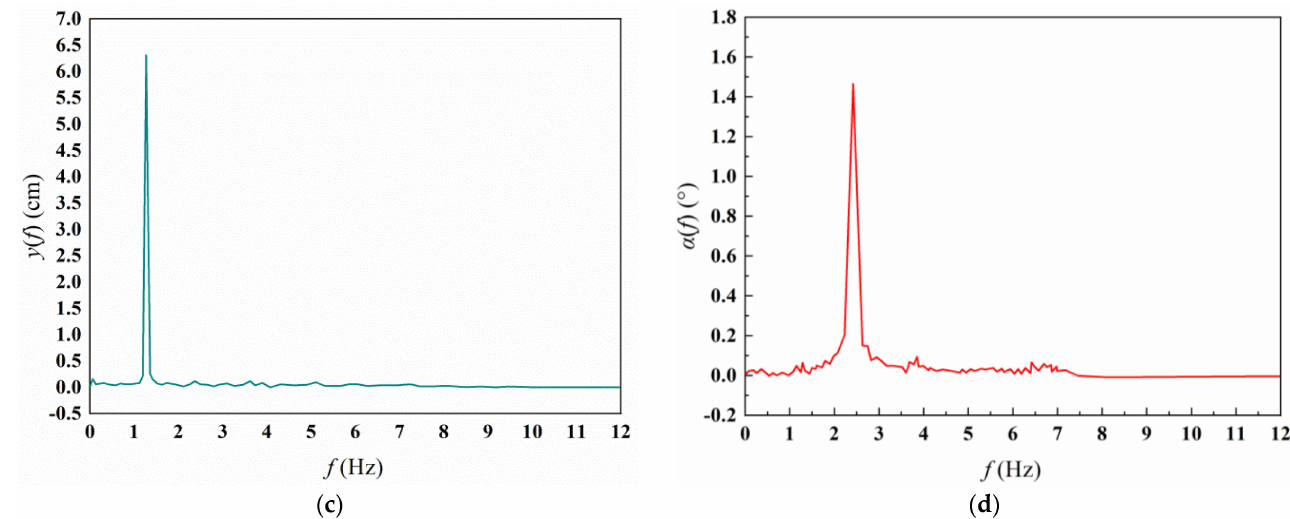
Figure 11. Time histories and frequency spectra of the vibration of the wind-retaining plate section, − 5 ◦ angle of attack, U = 29.1 m/s: ( a ) Vertical displacement time history; ( b ) Torsional displacement time history; ( c ) Vertical displacement spectrum; ( d ) Torsional displacement spectrum.